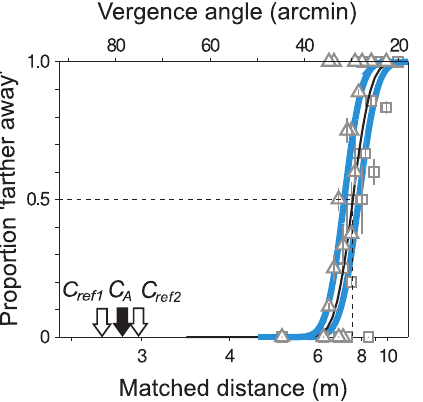
Figure 3. Inferring points of subjective equality (PSEs). Because we ran all the conditions simultaneously, the appropriate distance for the reference squares B and C could not be determined precisely in advance. Instead, two reference distances close to the expected value were chosen and interpolation (or, rarely, extrapolation) used to estimate the PSE that would have been obtained had the reference been positioned at the ‘ideal’ distance ( C A , black arrow). Two reference locations ( C ref1 and C ref2 , open arrows) and the corresponding psychometric functions are shown, together with the interpolated curve (black) and inferred PSE (dashed line). See also Figure S1.